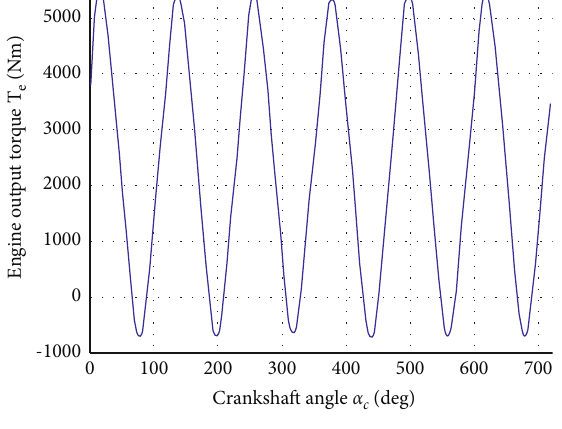
Figure 6: The engine output torque.